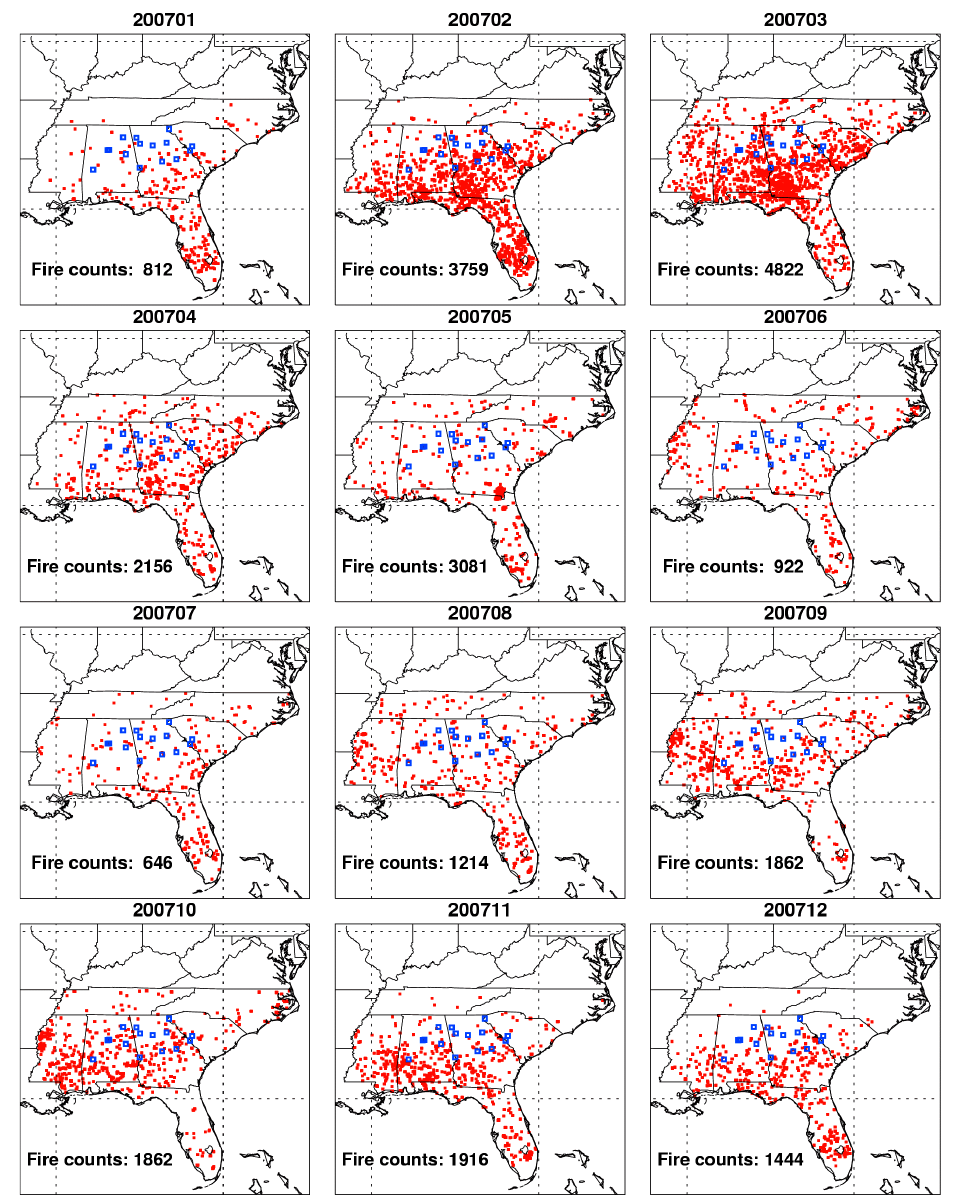
Fig. 6. Monthly MODIS Aqua fire counts (red points) in 2007 over seven states in the southeastern US. FRM sampling sites are shown as blue square